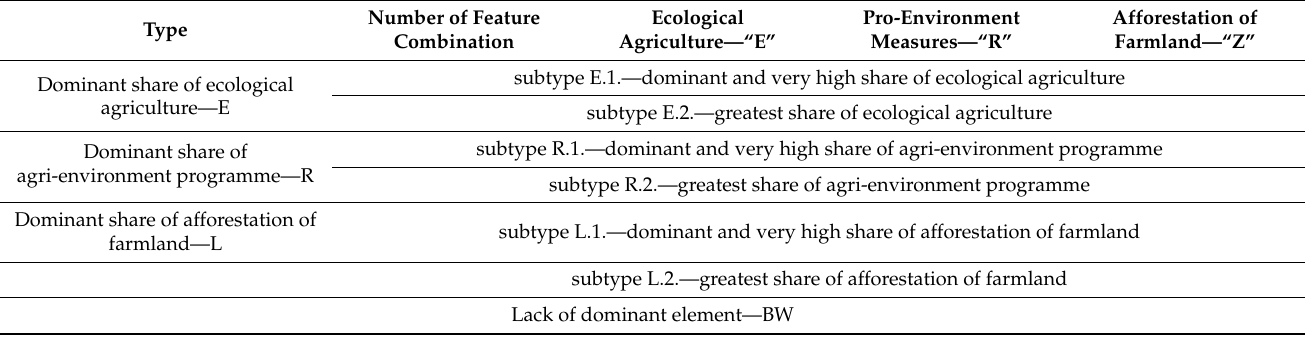
Table 5. Pro-environment measures in Polish agriculture—structural types.